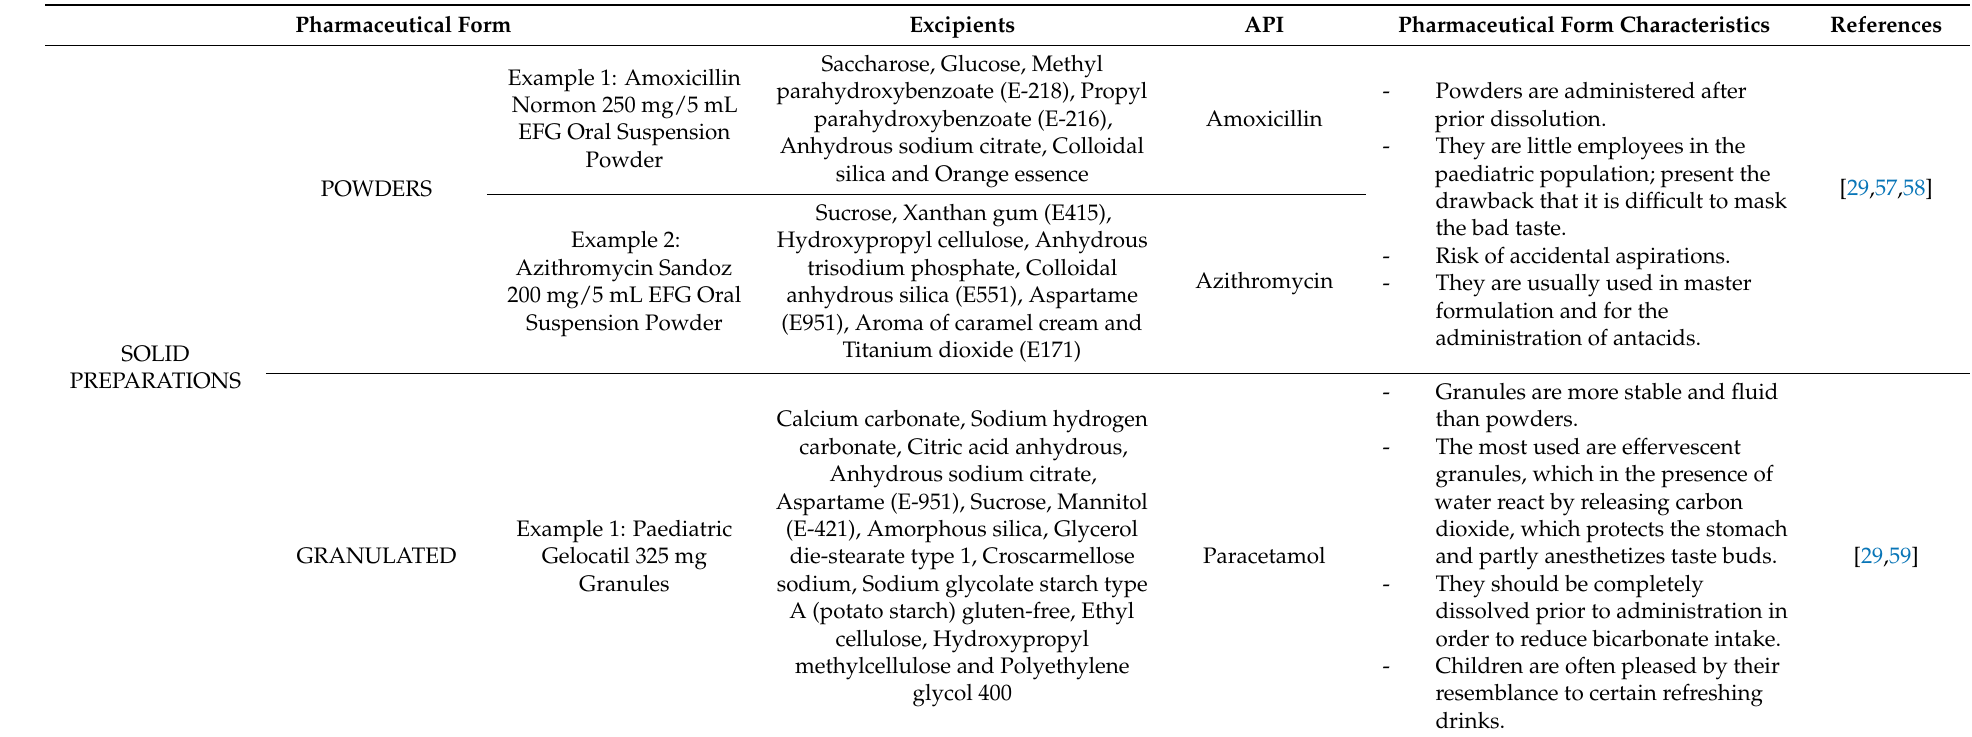
Table A2. Examples of solid and semisolid medicines used in Spain for paediatric population: List of excipients and relevant characteristics of FF (Performed consultation of CIMA database, September